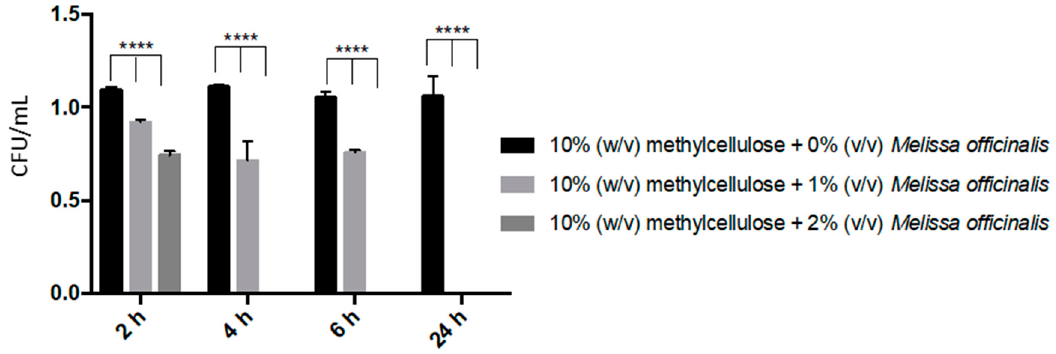
Figure 5. In vitro time-kill assay after 2, 4, 6 and 24 h of exposure of C. albicans to 10% ( w / v ) methylcellulose hydrogels with or without 1 or 2% ( v / v ) Melissa o ffi cinalis . **** = p <